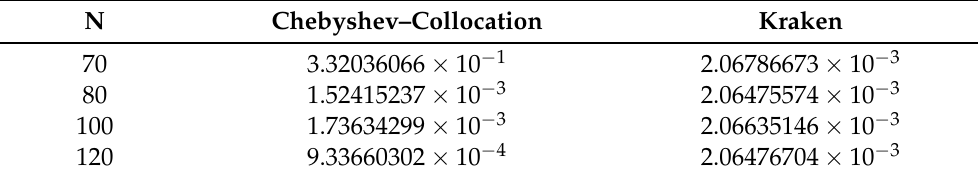
Table 6. The numerical calculation error at the sound source depth varies with N